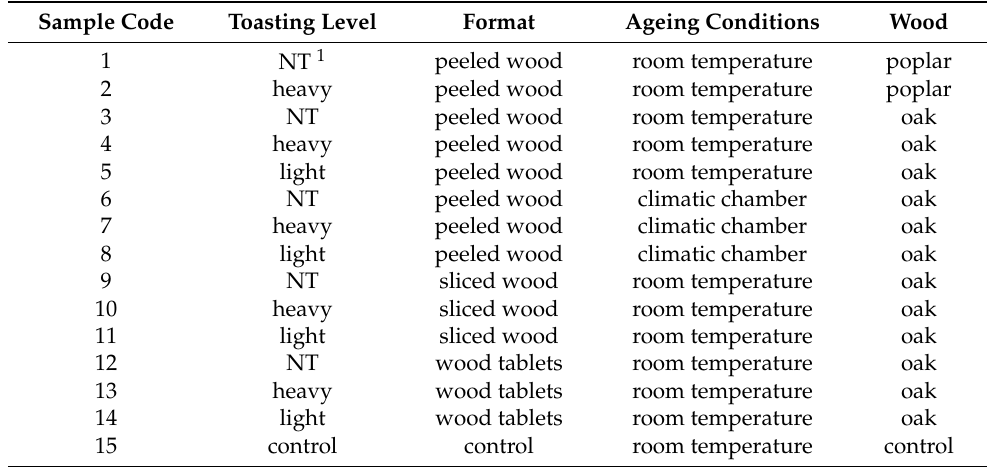
Table 1. Experimental plan adopted during the study. Sample